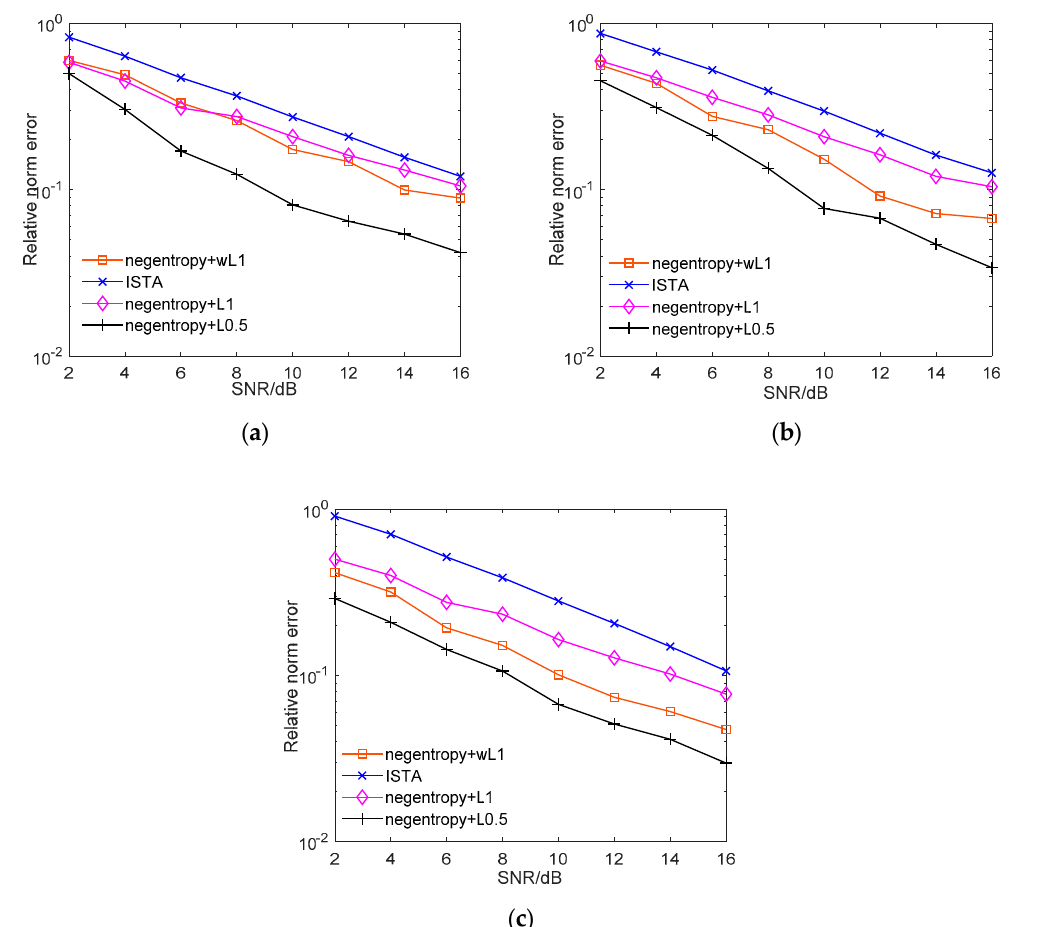
Figure 3. Relative norm error performance versus SNR. ( a ) Comparison between ISTA and proposed algorithm with 40% compression; ( b ) comparison between ISTA and proposed algorithm with 50% compression; ( c ) comparison between ISTA and proposed algorithm with 60% compression.